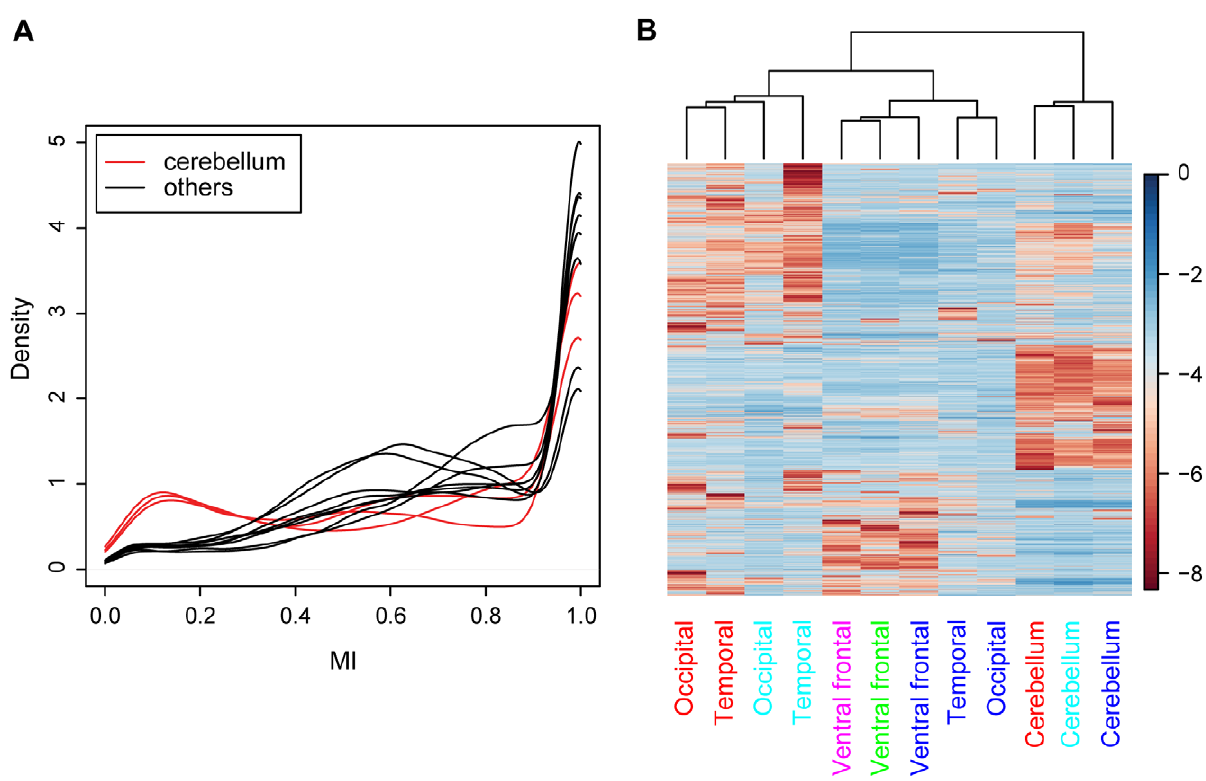
Figure 1. Methylation pattern of 12,180 probes. (A) Brain MI score distributions showing cerebellum samples with bimodal distributions in red and other brain regions in black. (B) Hierarchical clustering of methylation data. The heat map shows relative methylation differences depicted in (red) hypomethylated and (blue) hypermethylated log 2 (MI) scores (rows and columns corresponding to probes and samples, respectively). Dendrogram depicts clustering of samples by brain regions, where regions from the same subjects are color-coded.